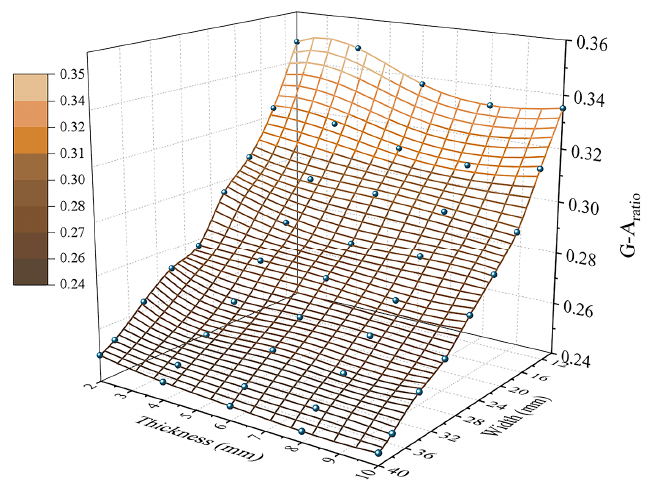
Figure 12. The G-A ratio varies with respect to thickness and width.